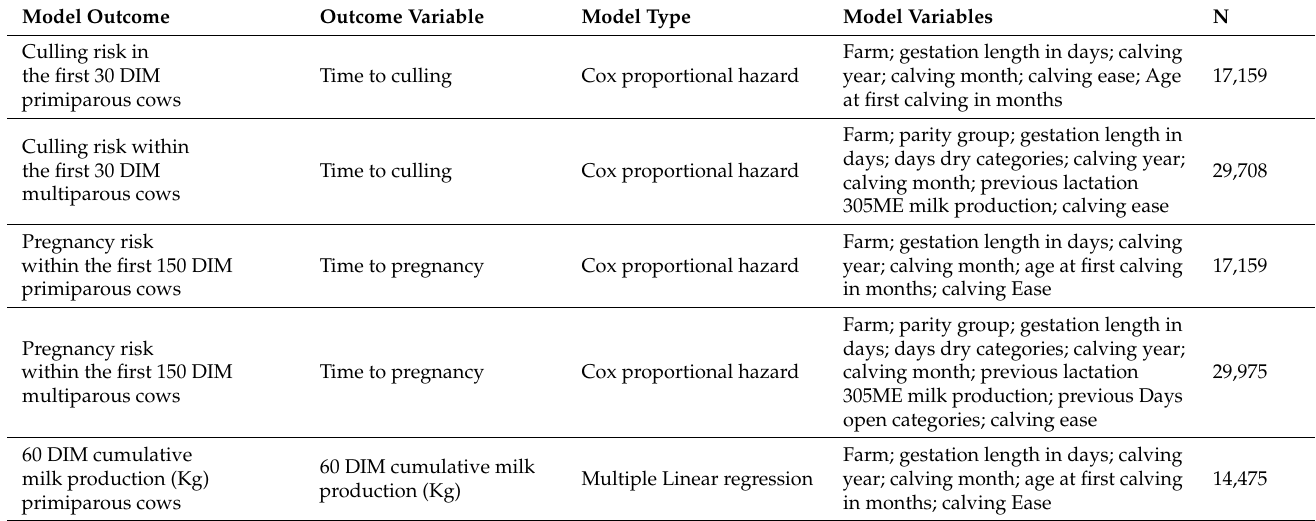
Table 2. Statistical models and variables included for the analysis of the association between calving ease and survival, fertility and milk